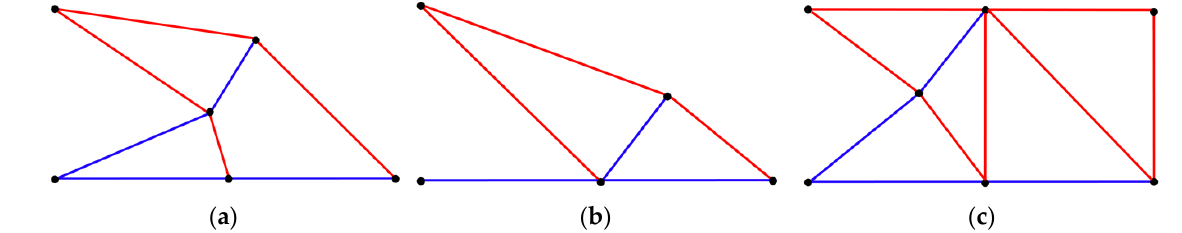
bination II; ( c ) Load case II with constraint combination I; ( d ) Load case II with constraint combina-